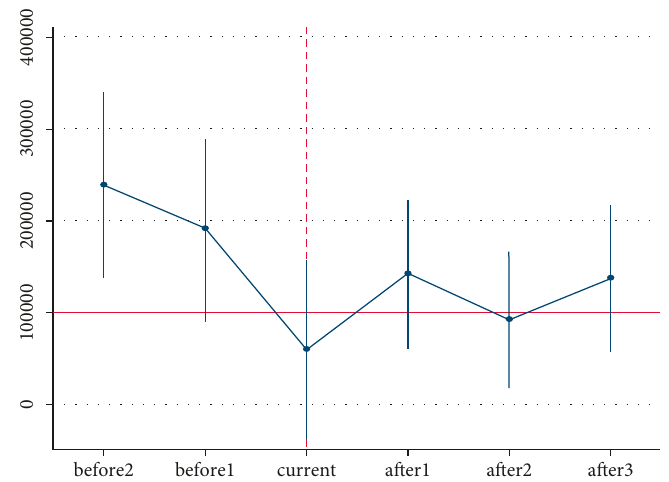
Figure 6: Parallel trends in domestic and inbound tourist arrival.